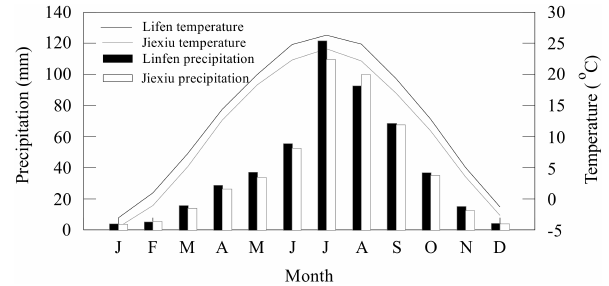
Fig. 2. Monthly precipitation and monthly mean temperature distri- bution of the two meteorological stations from 1954 to